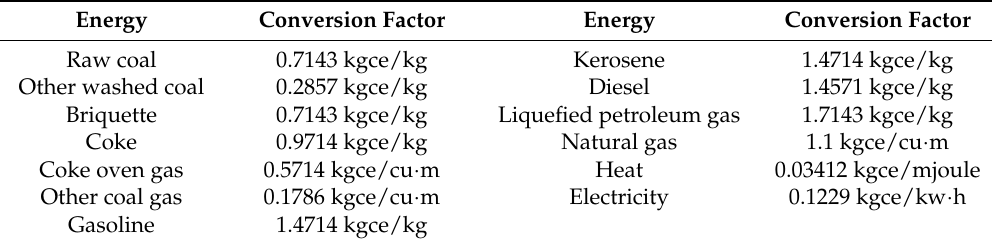
Table 1. Conversion factors from physical units to coal equivalent.